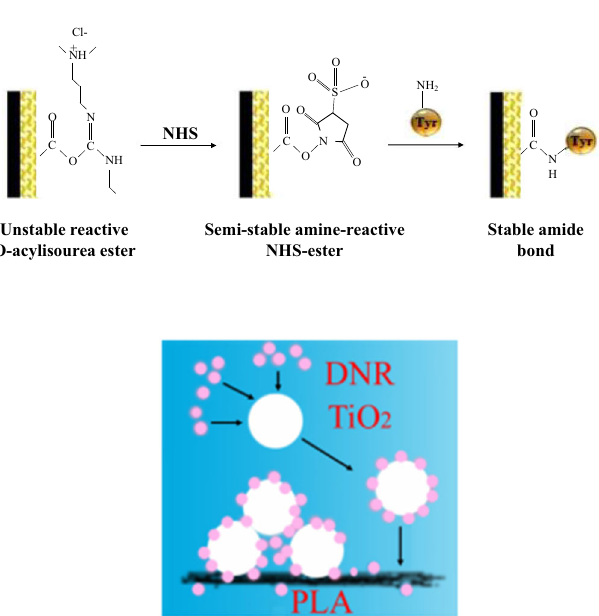
Fig. 5 Schematic diagram of the self-assembly of roxithromycin on